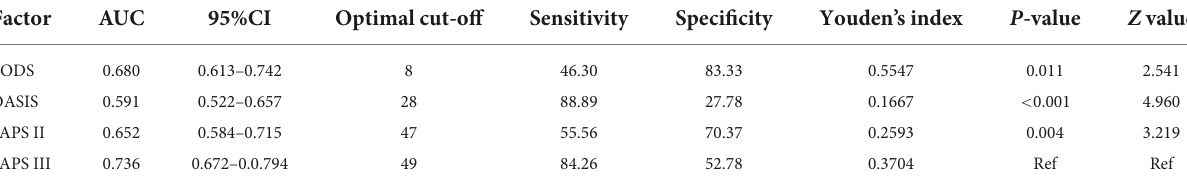
TABLE 7 Comparison of ROC curves (after